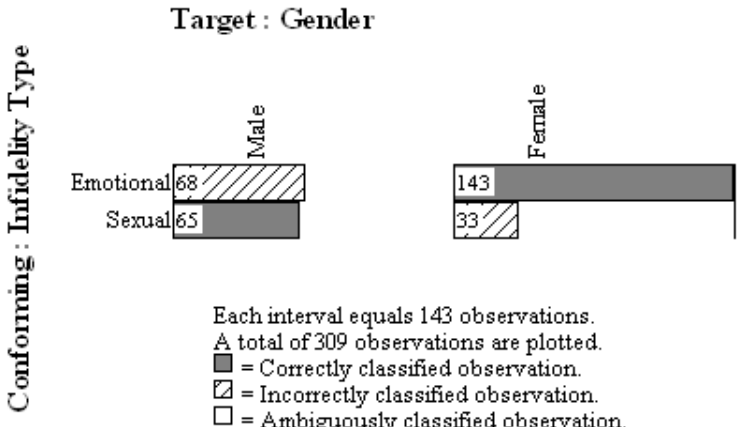
Figure 1. Multigram for Gender –> Infidelity Type Choice